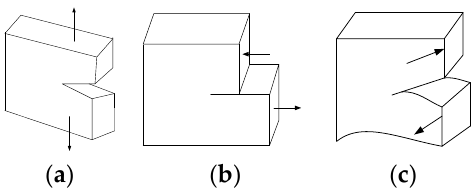
Figure 2. Three typical crack modes, ( a ) is the opening mode (Mode I), ( b ) is the edge-sliding mode (Mode II) and ( c ) is the tearing mode (Mode III).